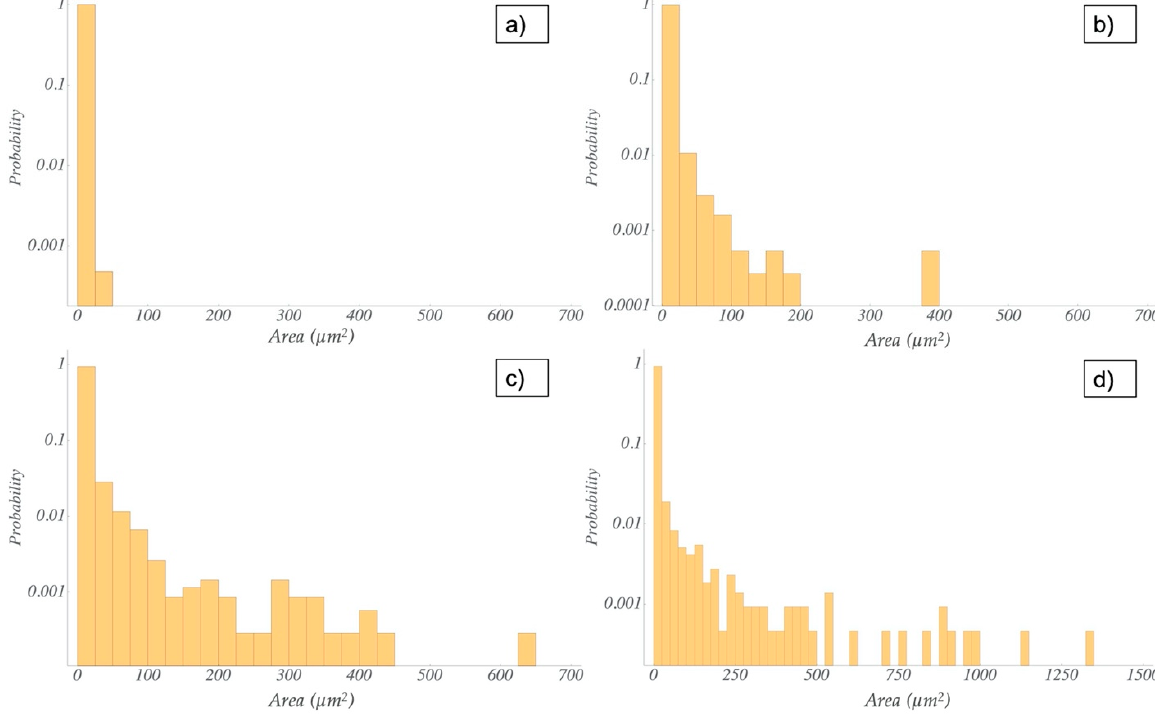
Figure 6. Comparison of the distribution of the agglomerate area size for the US dispersion for the 0.5 wt% filler grade and different filler: ( a ) CNF; ( b ) CNToxi; ( c ) CNT; ( d ) CNT